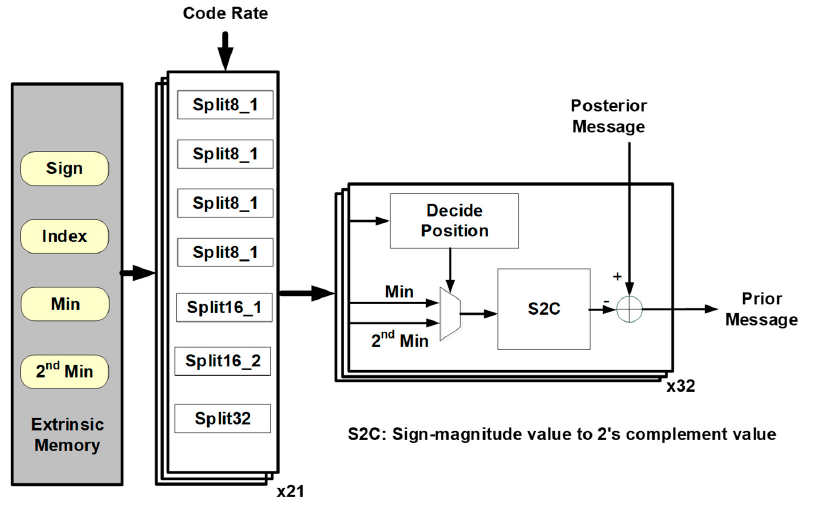
Figure 19. The architecture of the PMU.